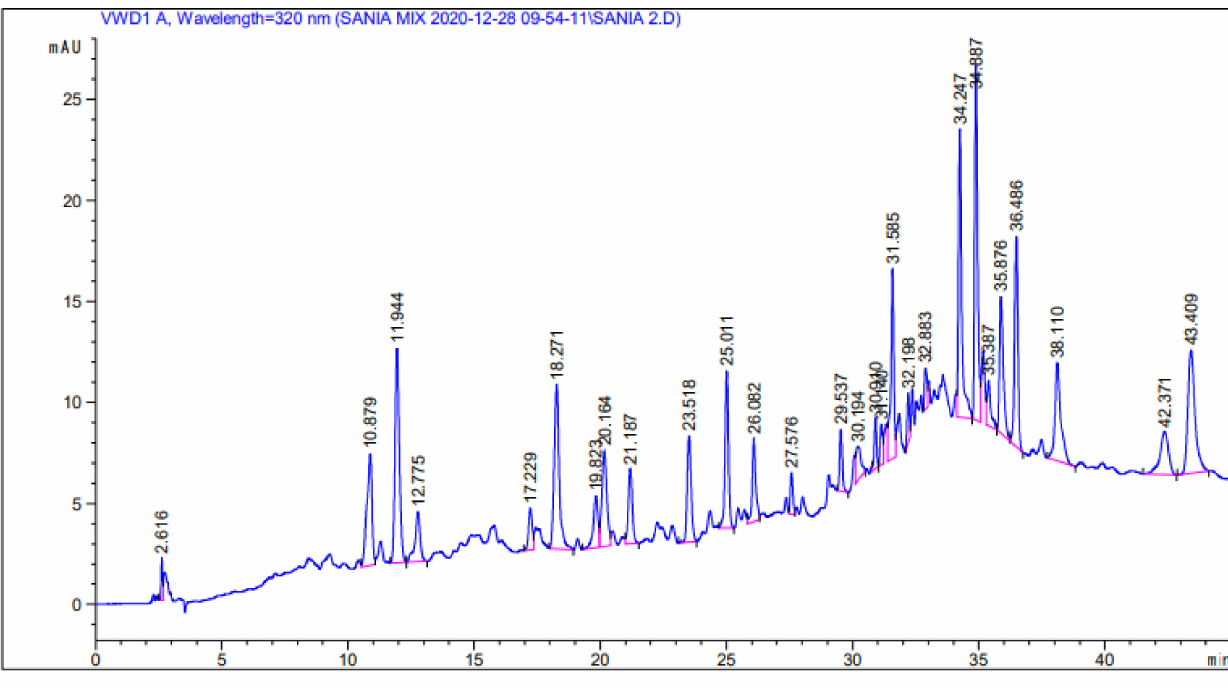
Figure 2. HPLC-UV chromatogram of bioactive compounds of the Cydonia oblonga Met +